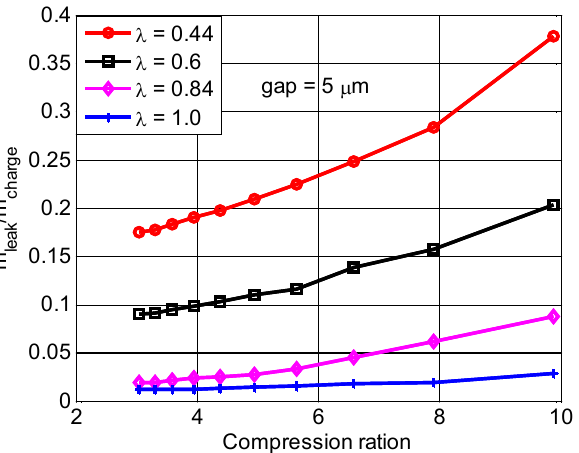
Figure 8. The effect of mass leakage on the compression ratio for different size factors.